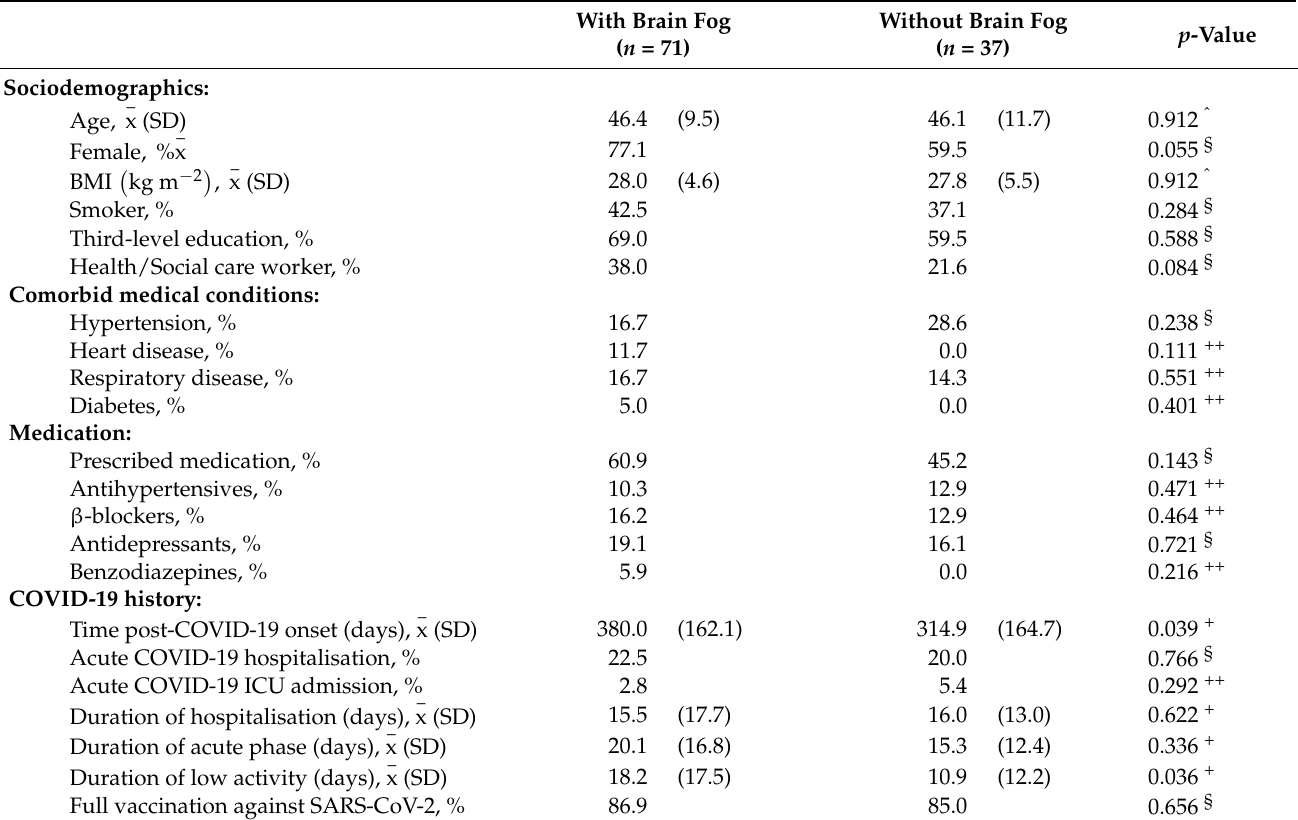
Table 1. Sociodemographics and medical history comparisons between participants with and without brain fog. With Brain Fog ( n = 71)